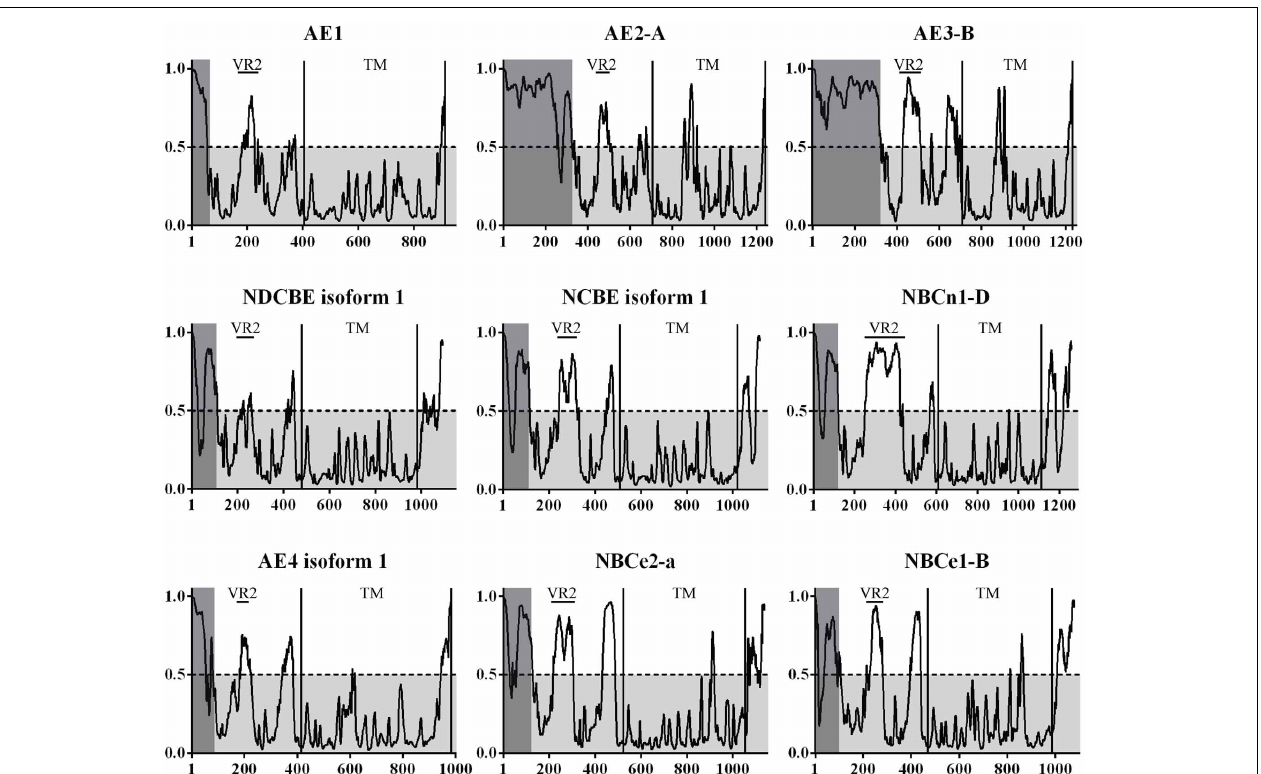
FIGURE 3 | The prediction of disorder in the bicarbonate transporters of the SLC4 family. Probability plots of the longest isoforms of SLC4A1-5 and SLC4A7-10 are presented here. A total of 35 isoforms were analyzed. On average, the highest probability of disorder is found in two regions of the N-terminal cytoplasmic domain in the SLC4 family. A high level of disorder is predicted for the variable regions 1 and 2 [VR1, VR2 (Boron et al., 2009)]. VR1 is highlighted in gray. This region was not visible in the Nt-AE1 structure and no experimental structural information exists for it. VR2 is marked on the plots and was modeled in the Nt-AE1 structure. In that structure the high